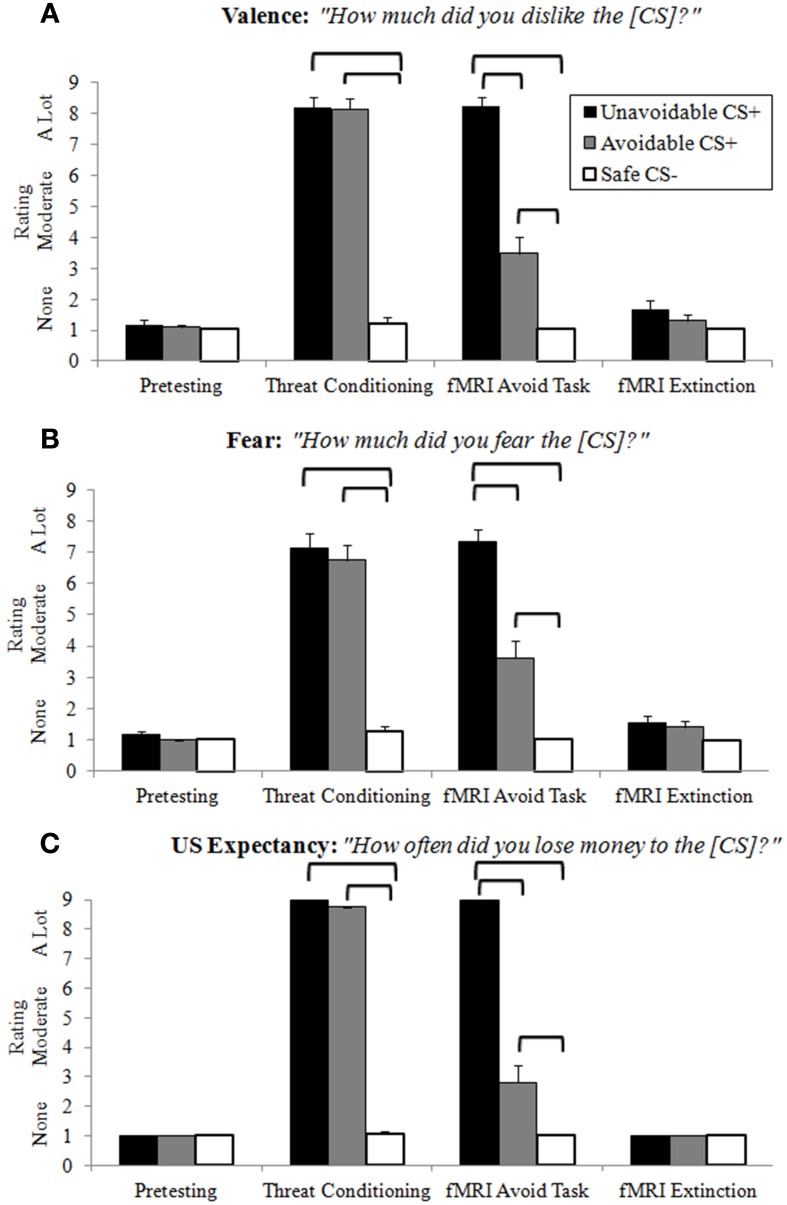
Retrospective CS ratings. Following each experimental condition, subjects rated how much they (A) disliked (negative valence), (B) feared, and (C) lost money (US expectancy) for each CS. No differences among CSs were observed after pretesting or extinction. Prior to neuroimaging, threat conditioning paired CS+s with the aversive US which produced significantly higher ratings for CS+s compared to the CS−, indicative of successful differential threat conditioning. For the delayed avoidance task, CS+s were rated significantly higher than the CS− and the Avoidable CS+ threat was rated significantly lower compared to the Unavoidable CS+, demonstrating that successful avoidance reduced threat appraisal. (Brackets highlight significant differences, p < 0.05 corrected. Bars represent 95% confidence intervals. See Supplemental Table 1 for details).